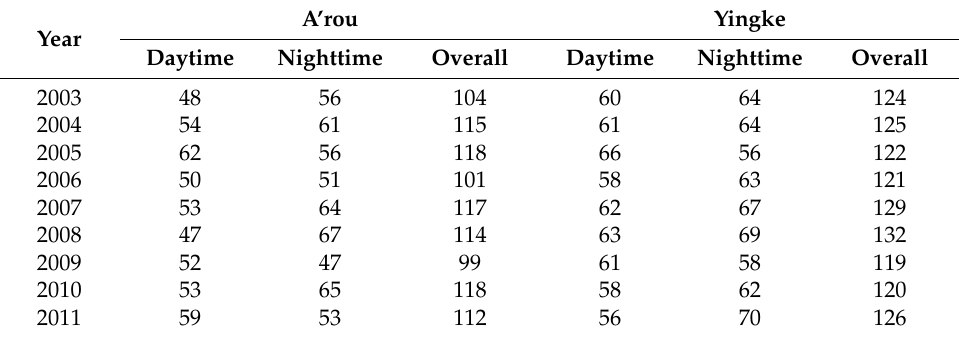
Figure 5. Temporal variations of AATSR-derived annual averaged LST at A’rou and Yingke site for 2003–2011. Table 4. The number of available cloud-free AATSR data for each site used in Figure 5.